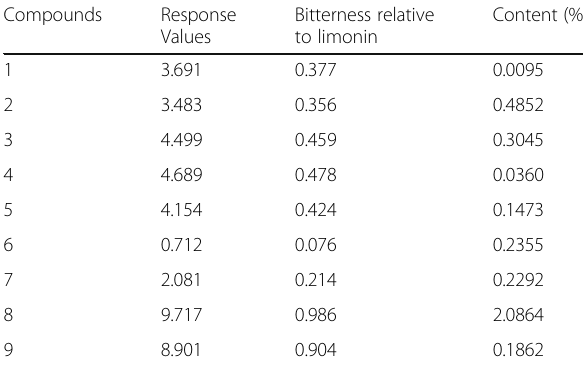
Table 1 Response values, bitterness relative to limonin,